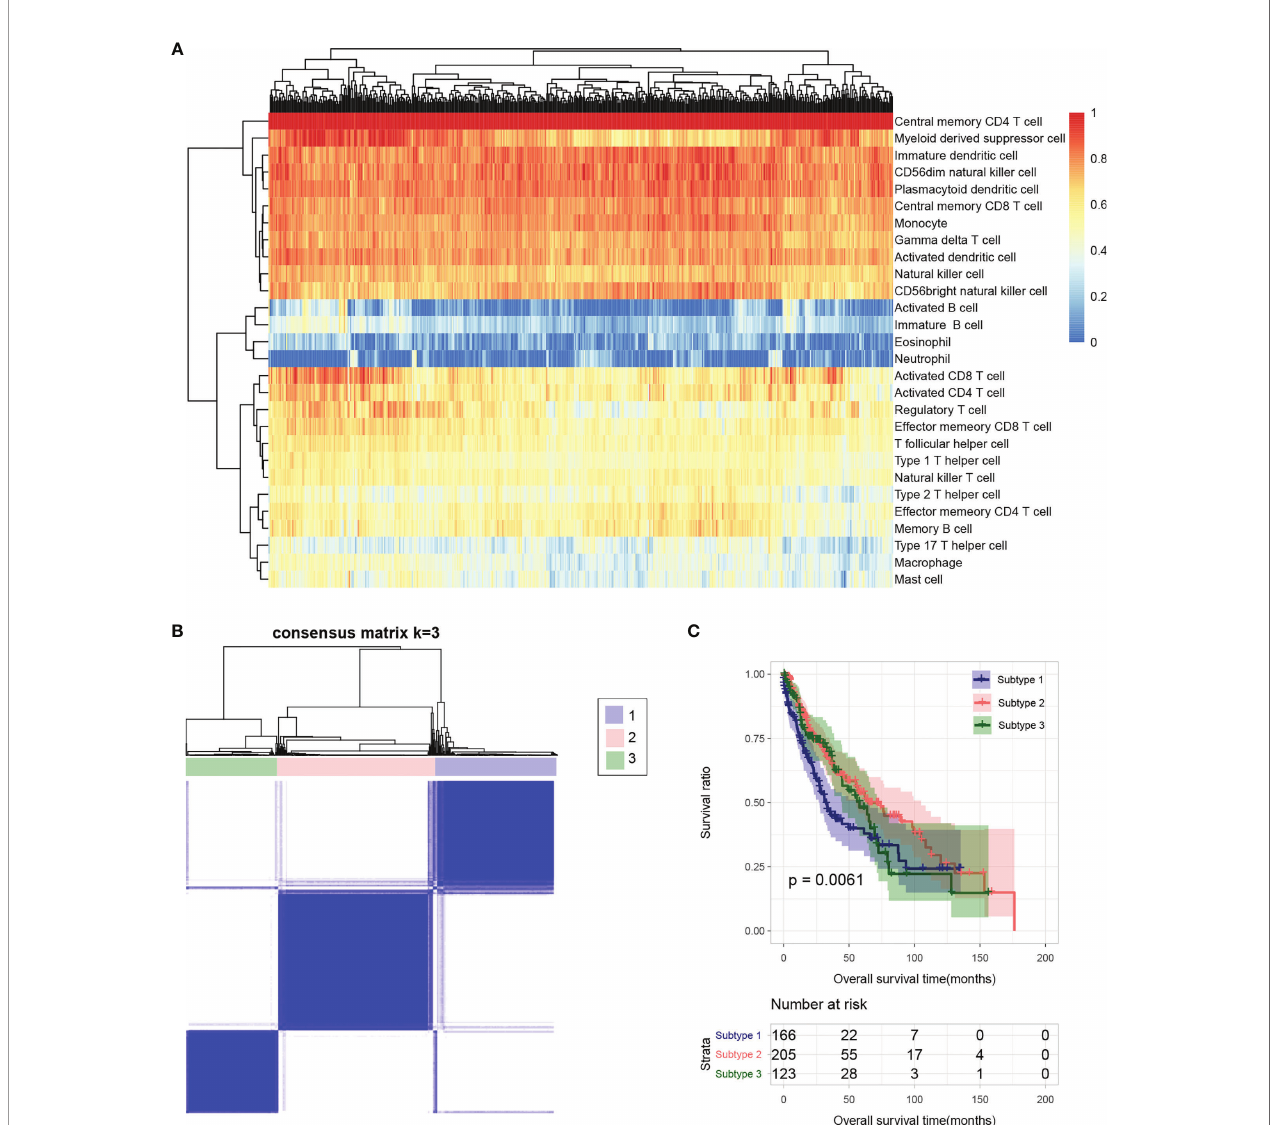
FIGURE 2 | (A) Heatmap of sample immune cell proportion evaluated based on ssGSEA. (B) Sample subtype analysis cluster diagram. (C) KM survival curves of different